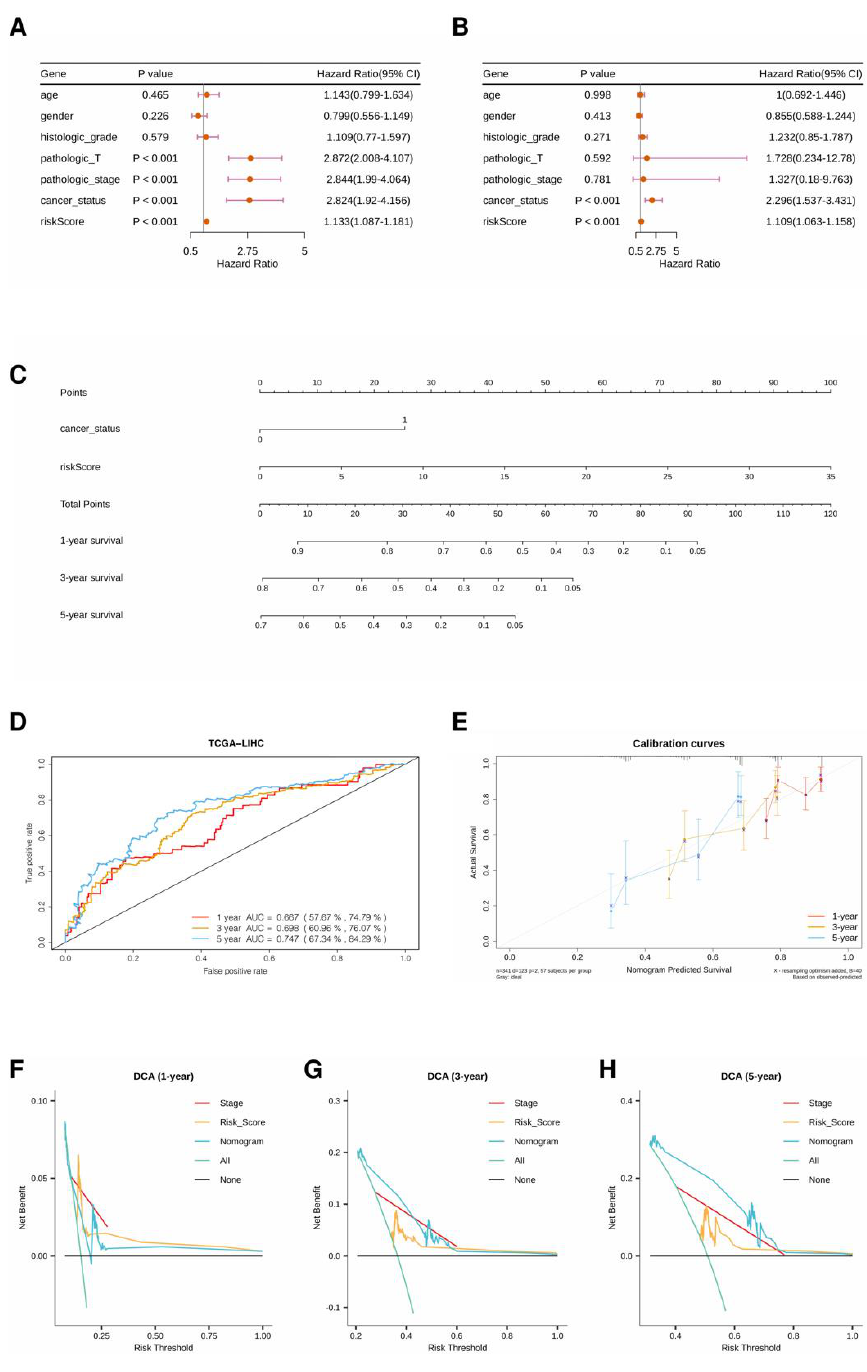
Figure 6. ( A ) Forest plot of univariate regression analysis. ( B ) Forest plot of multivariate regression analysis. ( C ) A nomogram incorporating cancer status and risk score for prognosis. ( D ) ROC curves of the nomogram with AUCs of 0.667, 0.698, and 0.747 at 1, 3, and 5 years, respectively. ( E ) Comparison of predicted and actual OS in the calibration curve. ( F – H ) Decision curve analyses of models in the TCGA-LIHC dataset.